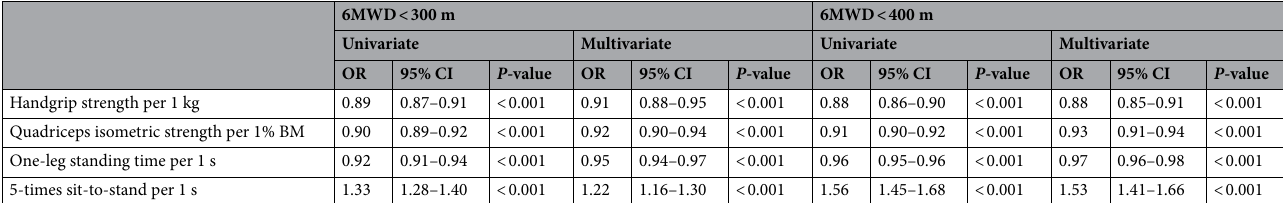
Table 2. Univariate and multivariate logistic regression for 6-minute walk distance < 300 m and 6-minute walk distance < 400 m. *Adjusted for age, sex, height, body mass, heart rate, SBP, current smoker, NYHA functional class, LVEF, GNRI, hemoglobin, eGFR, log BNP, and prior heart failure for 6MWD < 300 m and < 400 m. 6MWD, 6-minute walk distance; BNP, B-type natriuretic peptide; % BM, percentage of body mass; CI, confidence intervals; eGFR, estimated glomerular filtration; GNRI, geriatric nutritionl risk index; LVEF; left ventricular ejection fraction; NYHA, New York Heart Association; left ventricular ejection fraction; OR, odds ratio; SBP, systolic blood pressure.